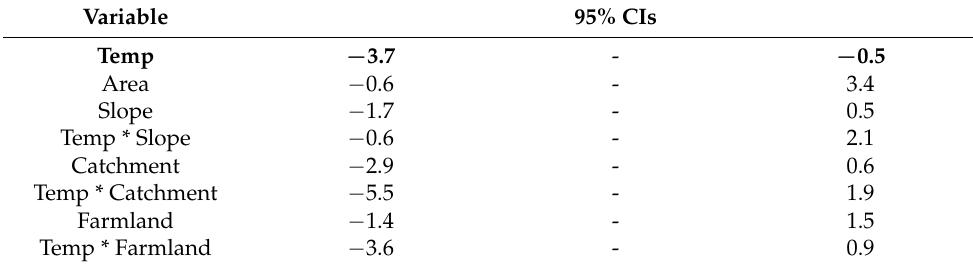
Table 4. Estimated parameters of each variable obtained by model averaging for the occurrence models. “Temp”, “Area”, “Slope”, “Catchment”, and “Farmland” represent the mean summer water temperature, survey area, stream slope, catchment size and proportion of farmland, respectively. “Temp * Slope”, “Temp * Catchment”, and “Temp * Farmland” indicate the interactive terms between the mean summer water temperature and other environmental factors. Influential variables (i.e., the variables for which the 95% confidence intervals (CIs) did not include 0) are shown in bold.